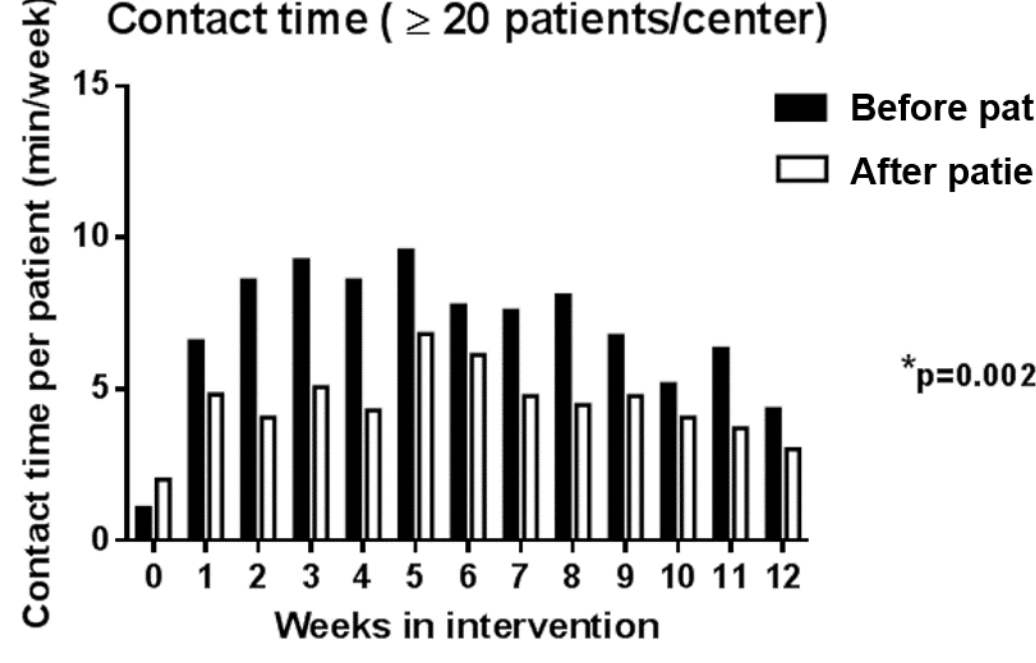
Figure 4. Contact time throughout the intervention (only including centers with more than 20 patients). The black bars represent the mean contact time (in min per week) per patient from the first 10 patients that were recruited in each center. White bars represent the mean contact time (in min per week) per patient from the patients that were recruited at a later stage. P value indicates difference between the total cumulated contact time over the 12 weeks between patients recruited in early stage versus later